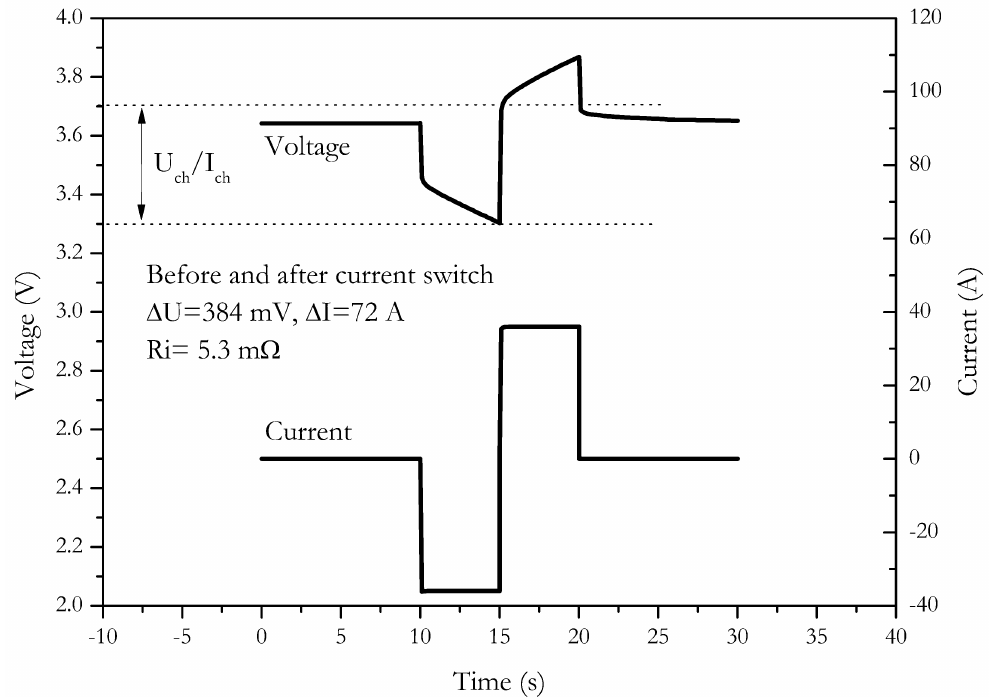
Figure 8. Measurement of internal resistance by switching current from discharge to